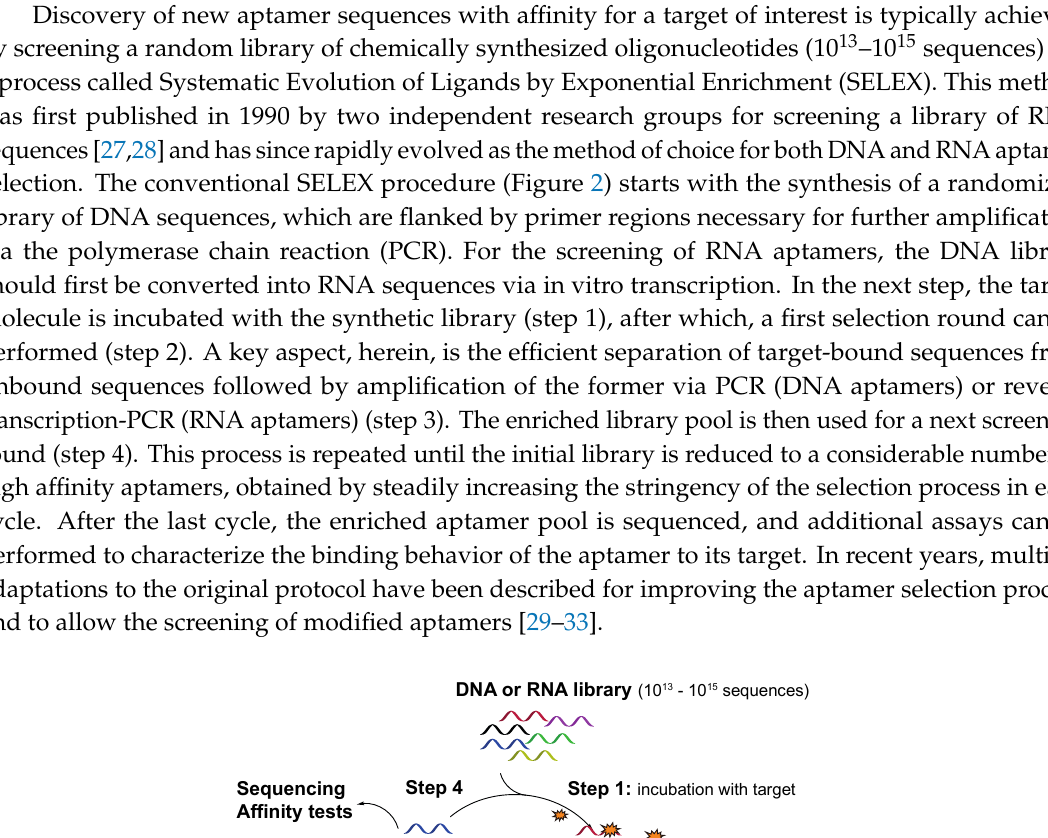
Figure 1. Equilibrium between the unfolded aptamer state ( I ) and its binding competent state ( II ) with corresponding equilibrium constant K F . The binding competent state ( II ) is able to bind the target (conformation III ), which is characterized by the dissociation constant K D .